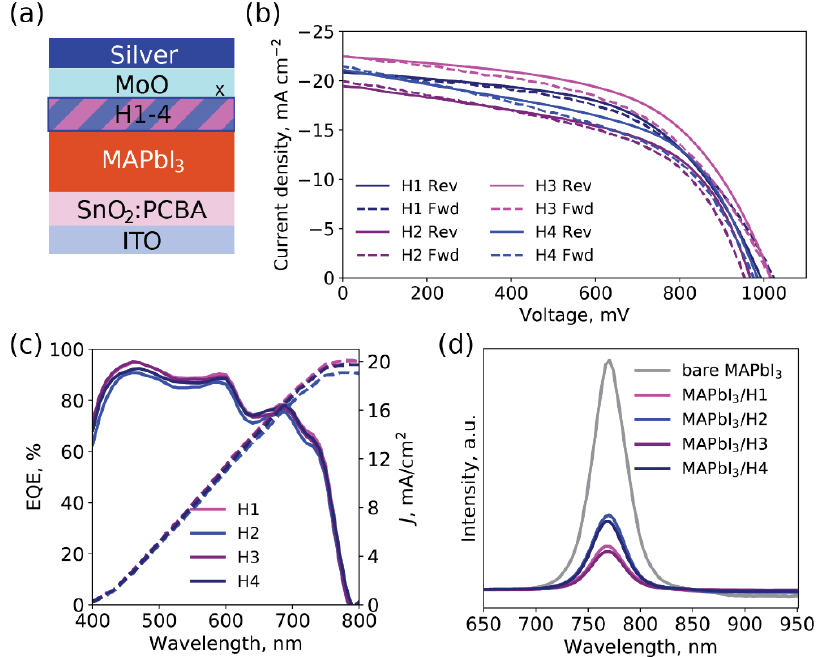
Figure 4. Configuration of PSCs ( a ), J-V curves of PSCs with H1-4 ( b ), EQE spectra ( c ), and PL spectra for substrates with configuration glass/perovskite/HTM ( d ). Table 1. Photovoltaic performance of PSCs based on H1 - 4